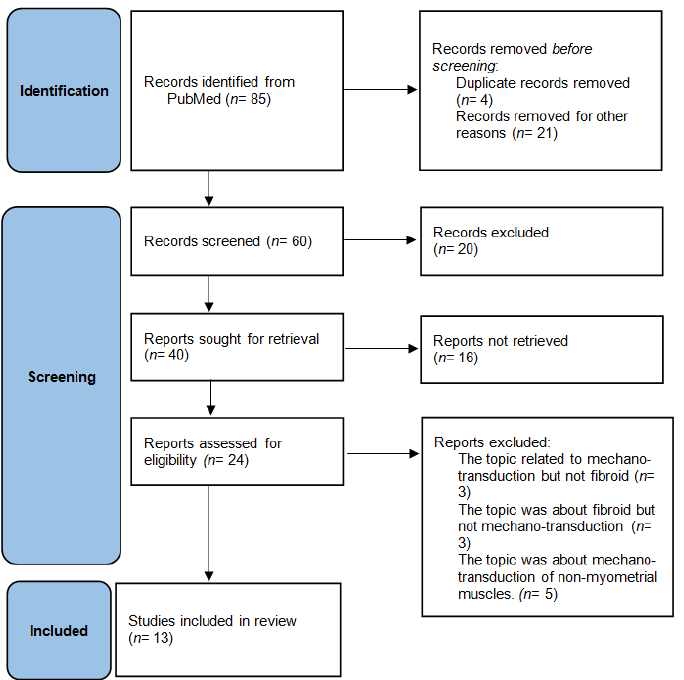
Figure 3. Flowchart used for searching and selecting articles in the narrative review from databases (according to PRISMA 2020).